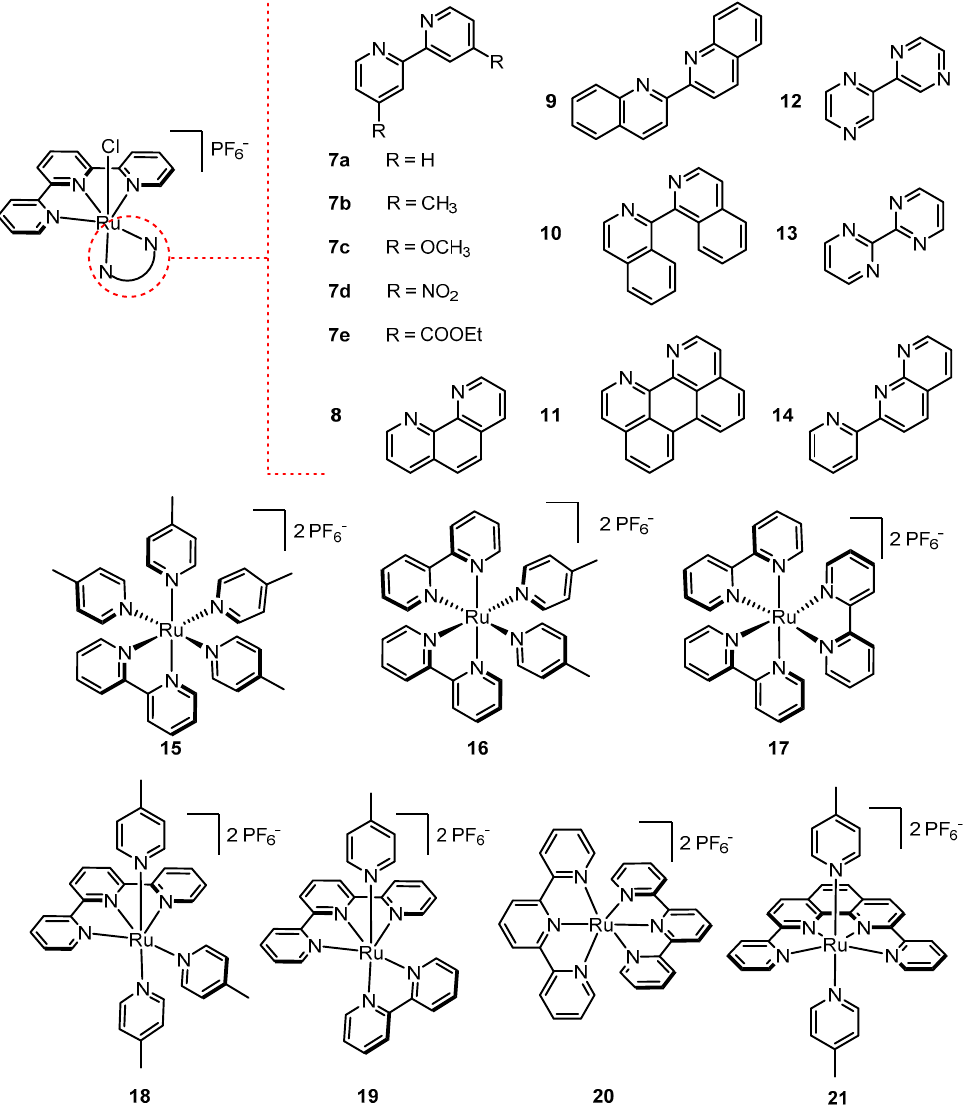
Figure 7. The series of mononuclear Ru-polypyridyl complexes tested by Thummel’s group for catalytic activity in the presence of Ce IV .